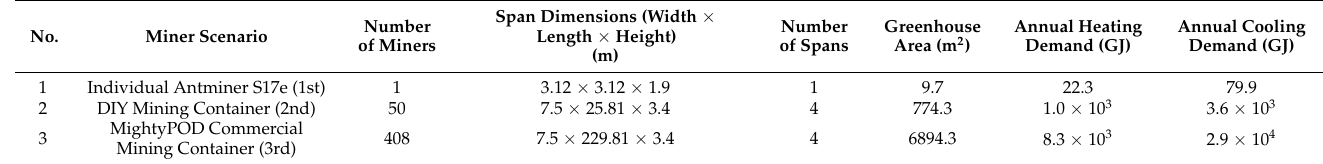
Table 3. The characteristics of the greenhouses designed for three miner scenarios in London, ON.